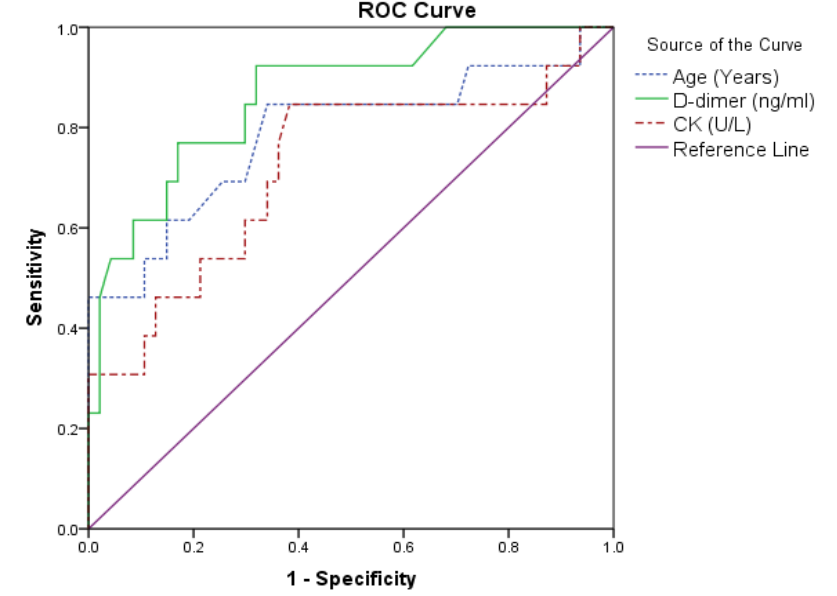
Figure 1. Parameters of the high-value predictors of mortality.